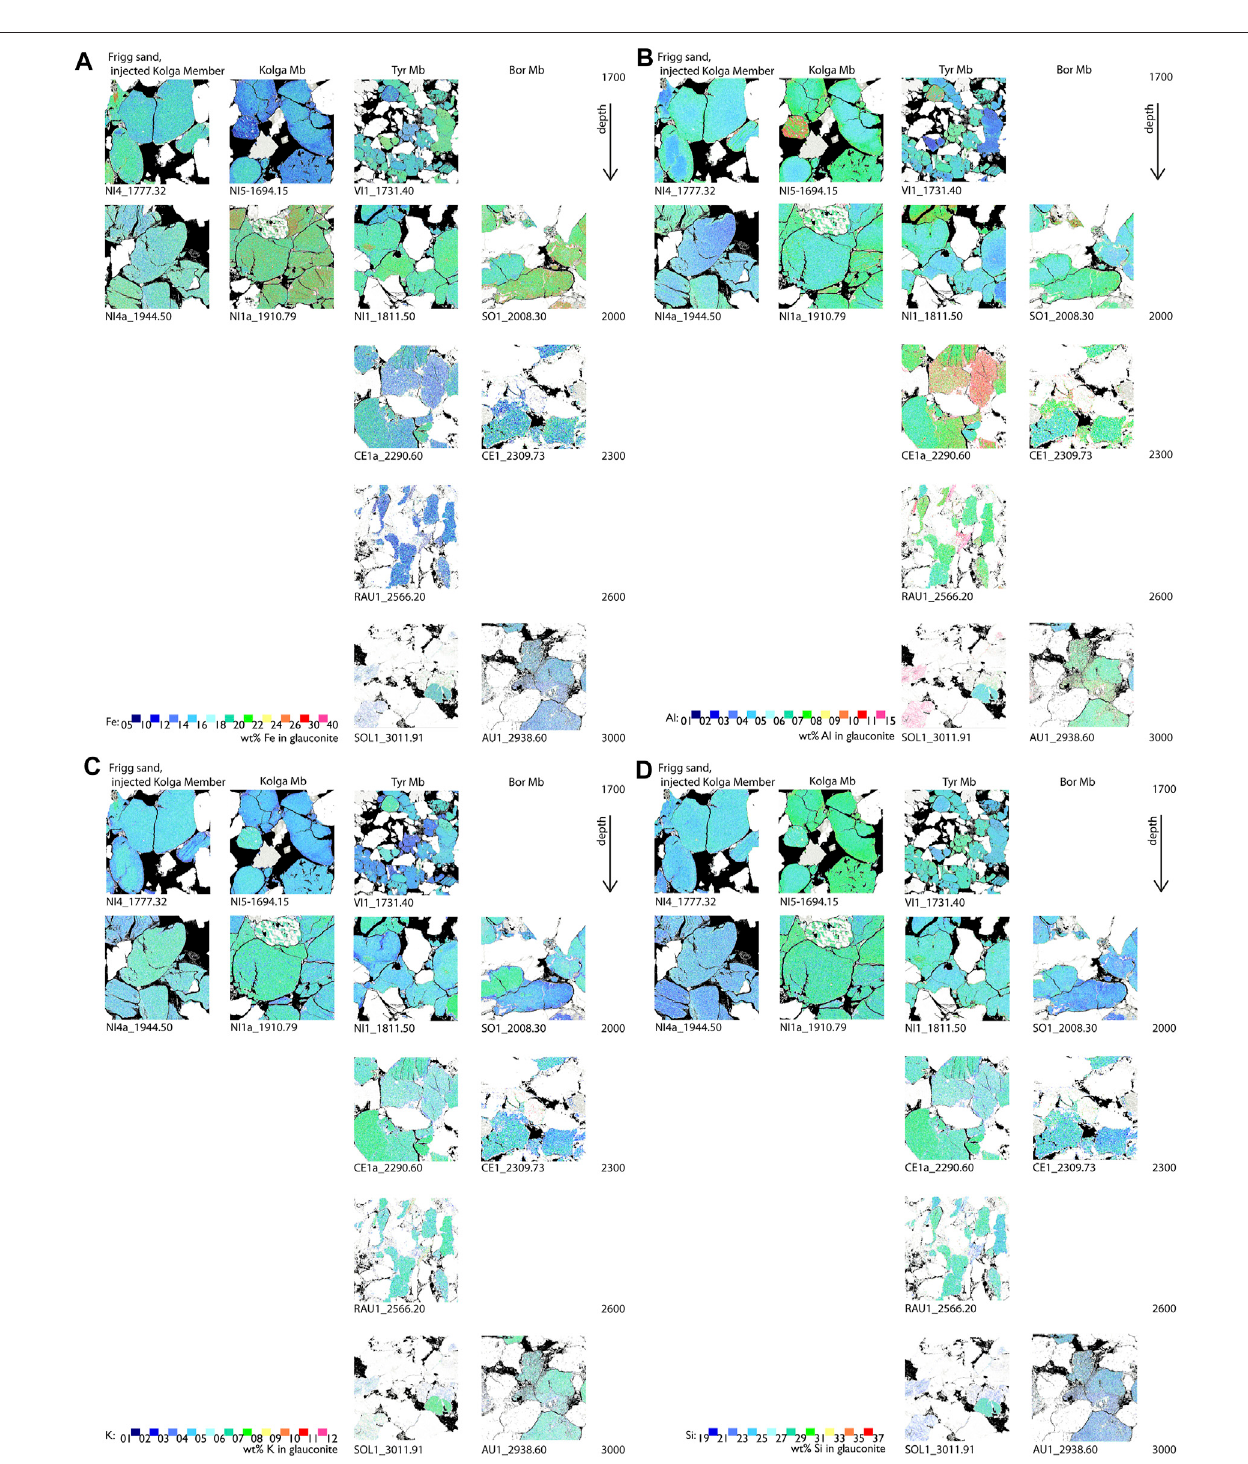
FIGURE2| Variationinglauconiticclastcompositionofthe fi vestudiedsand- fl owsfortheelements (A) iron(Fe), (B) aluminium(Al), (C) potassium(K)and (D) silicon (Si) with increasing depth. All other minerals in the sample are coloured white. Porosity in the sample is shown in black. A large version of the fi gure is provided as Supplementary Figure S2